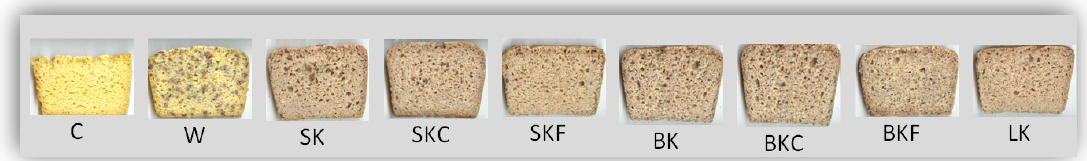
Figure 5. Appearance of gluten-free bread with whole and ground flax seeds. C—control gluten-free bread, W—gluten-free bread with whole flaxseeds, SK, SKC, SKF, BK, BKC, BKF, LK—gluten-free